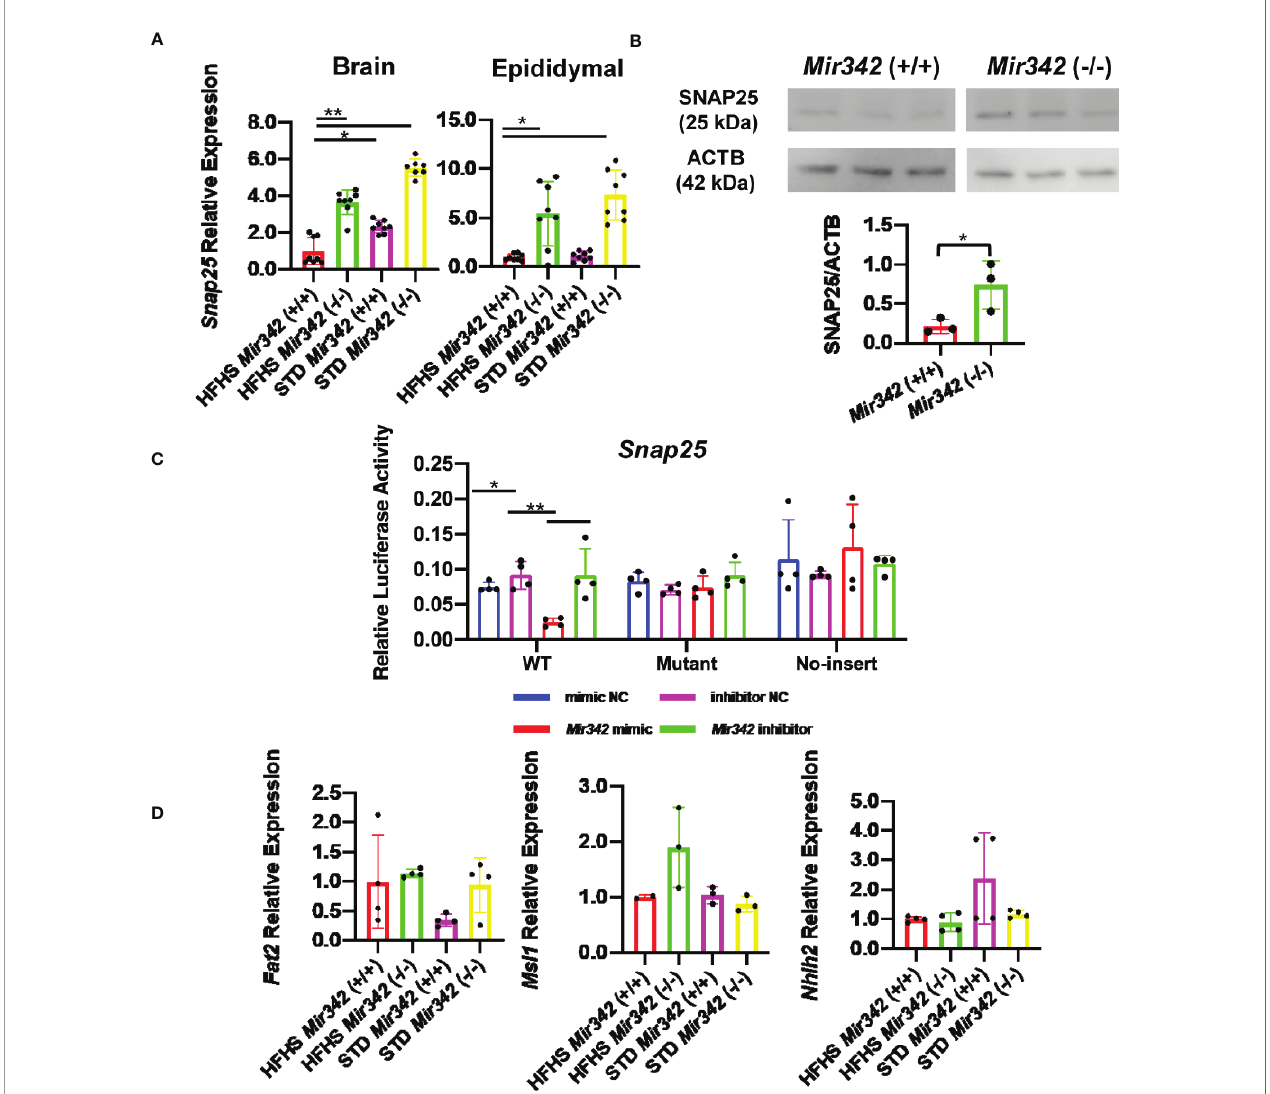
FIGURE 6 | The expression and reporter assay of Snap25 (synaptosomal-associated protein, 25kDa). (A) Relative mRNA expression of Snap25 normalized by Rplp0 and Rn18s in brain and epididymal fat tissues detected by RT-qPCR. (B) Western blot analyses and quanti fi cation of SNAP25 protein levels in hypothalamus. (C) Dual-luciferase reporter assay. pmirGLO-Snap25 WT 3 ’ -UTR, pmirGLO-Snap25 MT 3 ’ -UTR, and pmirGLO no-insert control plasmids were cotransfected with Mir342 mimic, Mir342 inhibitor, negative control siRNA (mimic NC), inhibitor negative control (inhibitor NC) into HEK293T cells, respectively. (D) The expression of predicted target genes (Fat2, Msi1 and Nhlh2) in brain. Data are analyzed by independent t-test or one-way ANOVA with a Tukey test. All data are presented as mean ± SD (*p < 0.05; **p <